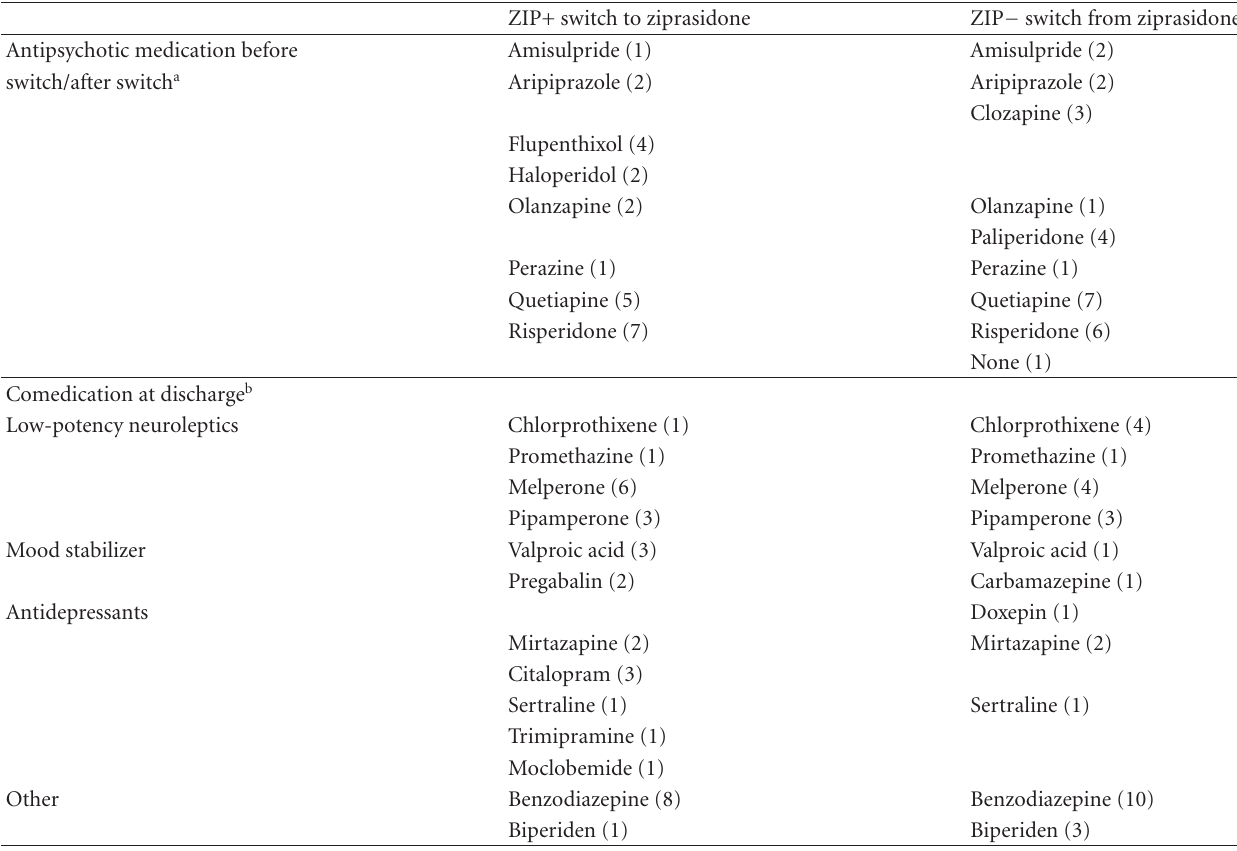
Table 2: Switching from or to ZIP: psychotropic medication.